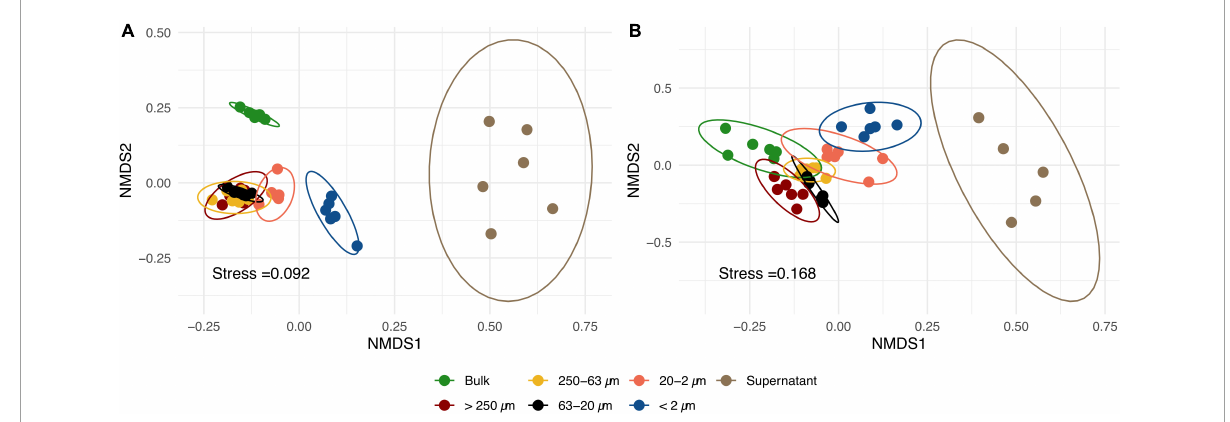
FIGURE2 Non-metric multidimensional scaling (NMDS) of bacterial (A) and fungal (B) ribosomal intergenic spacer analysis (RISA) band profiles of different particle size fractions (PSFs) and bulk soil samples based on Bray-Curtis dissimilarity matrices. Each point represents one replicate ( n = 6) and confidence ellipses are plotted for each sample